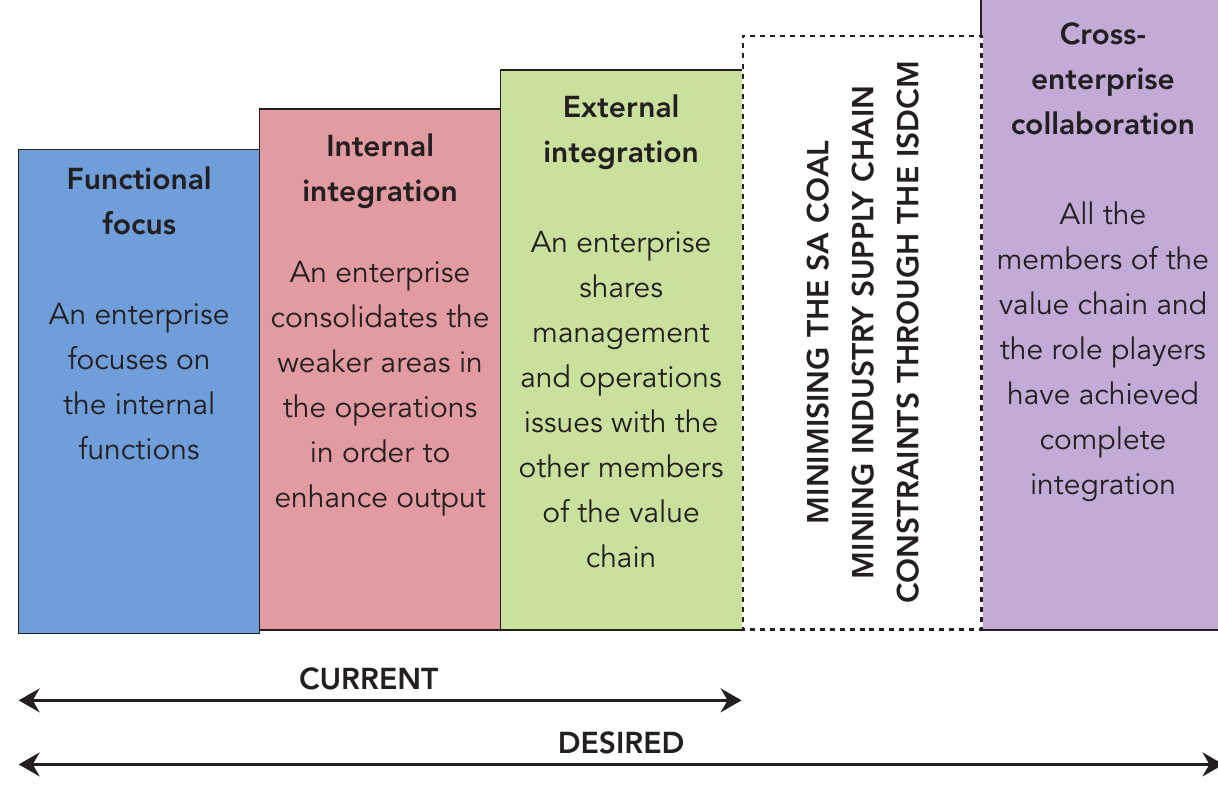
Figure 4: A model towards efficient cross-enterprise collaboration within the South African coal mining industry Source: Adapted from Super Group (2005,